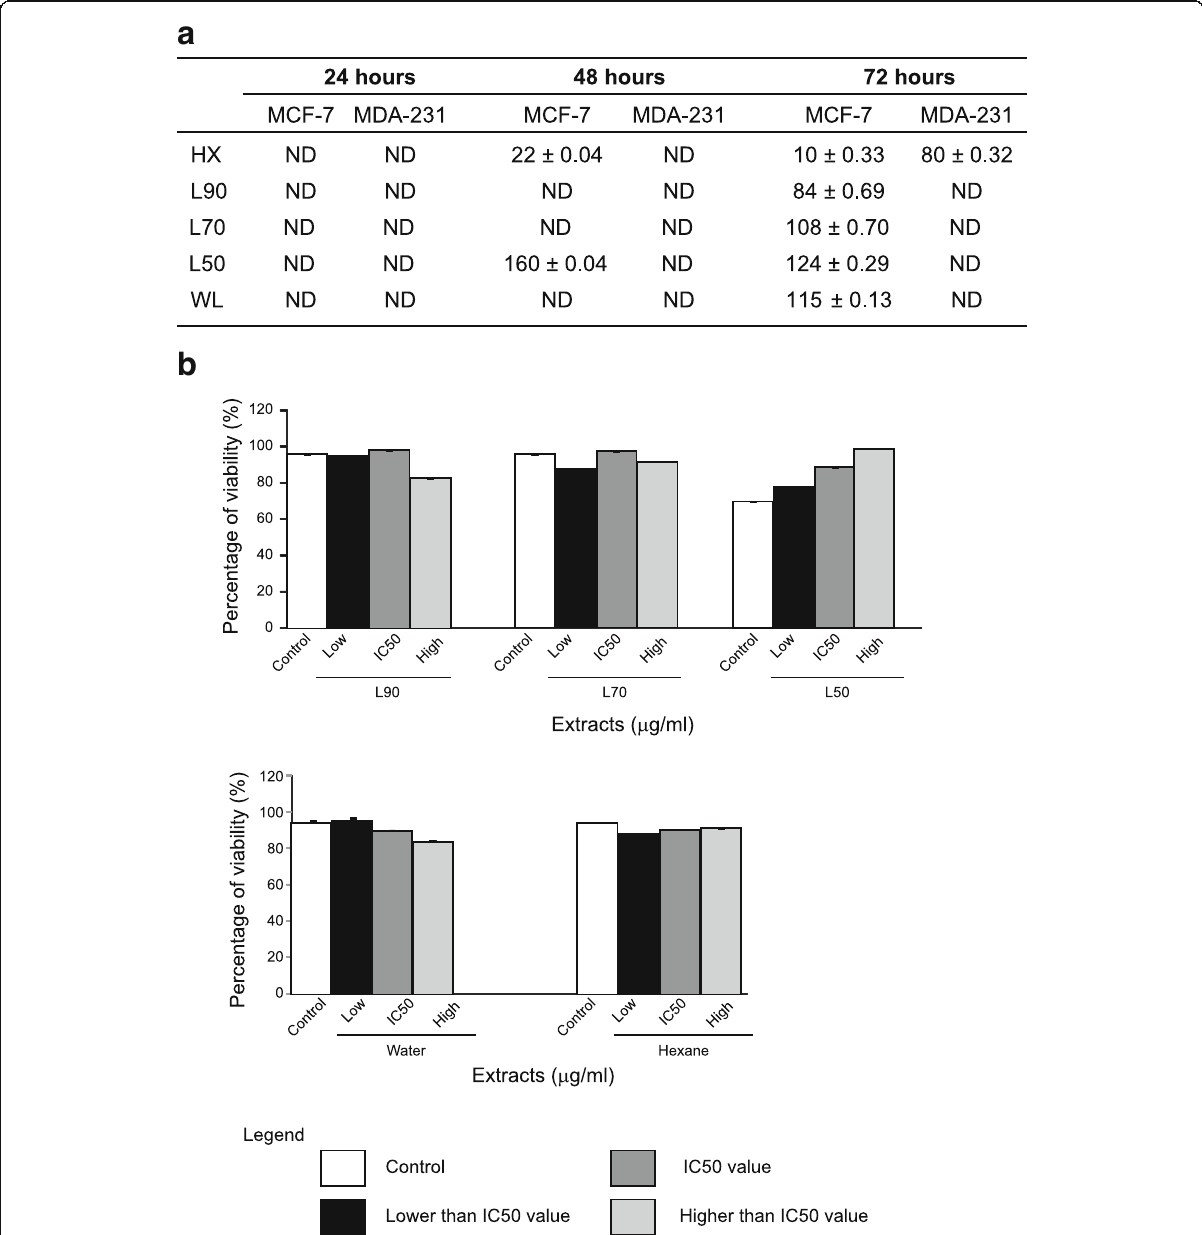
Fig. 1 Effects of B. frutescens leaves extracts on cell viability. a IC 50 values were determined using cell viability assay in MCF-7 and MDA-MB 231 cells treated with either hexane, L90, L70, L50 or water extracts after 24, 48 and 72 h. b Normal mammary epithelial cells (MCF-10A) were treated with either ( a ) L90, L70 or L50 or ( b ) water or hexane extract of B. frutescens leaves for 72 h at three different concentrations; lower than IC 50 value (low), IC 50 value (IC 50 ) and higher than IC 50 value (high). Data is expressed as mean ± standard error mean based on three independent experiments with triplicate wells for each